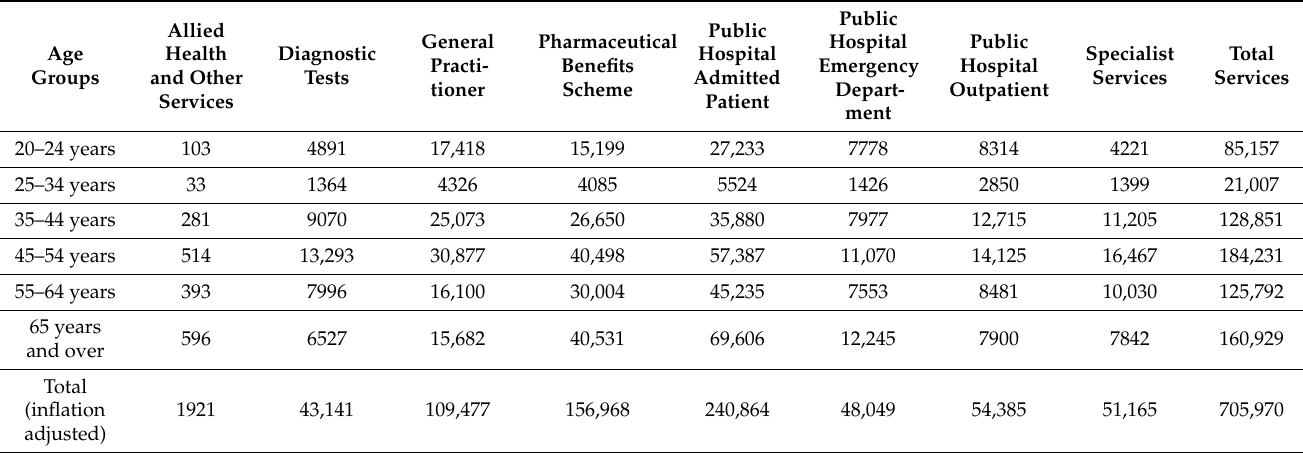
Table A6. Extra costs incurred due to LHL for people diagnosed with respiratory disorders in the Blacktown LGA (Domain 6).